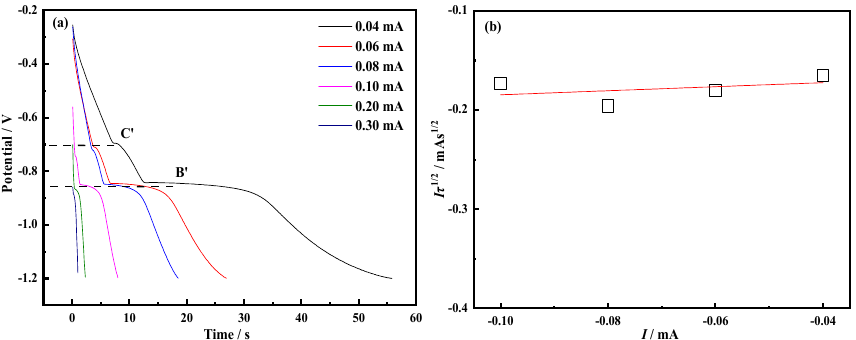
Figure 5. ( a ) The chronopotential curve under different currents; ( b ) the correlation between the